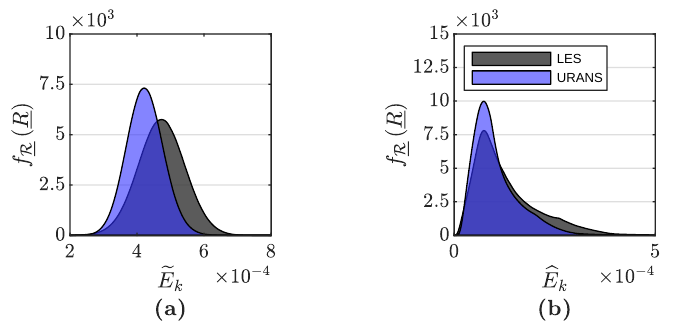
Figure 15. Probability density functions for the random responses: ( a ) integral mean global kinetic energy (cid:101) E k and ( b ) mean absolute deviation to the reference case of the global kinetic energy (cid:98) E k .